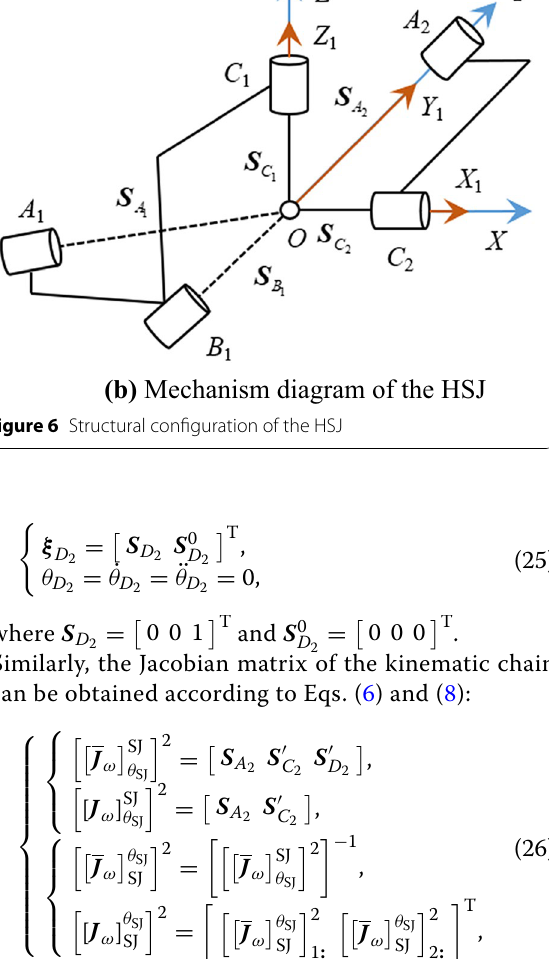
(a) Three-dimensional model of the HSJ